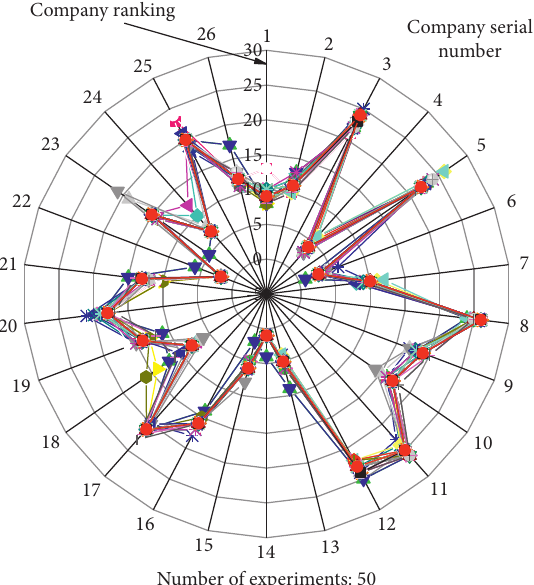
Figure 2: Traditional VIKOR parameter V sensitivity analysis